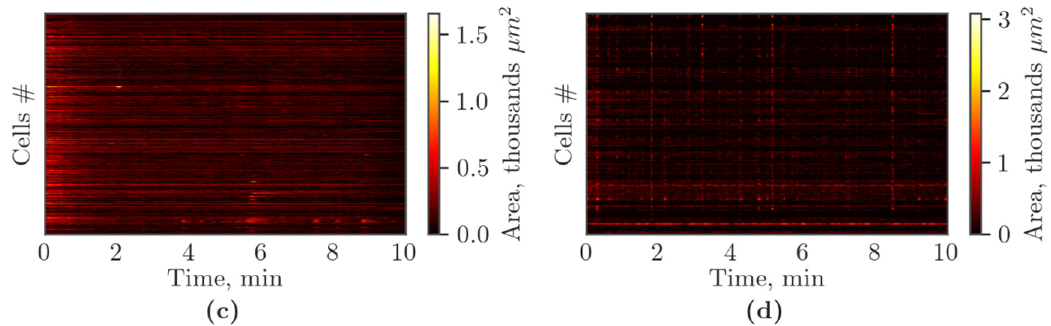
Figure 8. Representative raster diagrams of spontaneous calcium activity of primary cortical cultures on the third day of the post-hypoxic period. The X -axis represents the time of recording; the Y -axis represents the number (#) of active cells. The lighter the point, the higher area of fluorescence event in the cell: ( a ) Sham, ( b ) Gap19, ( c ) Hypoxia, ( d ) Hypoxia+Gap19.